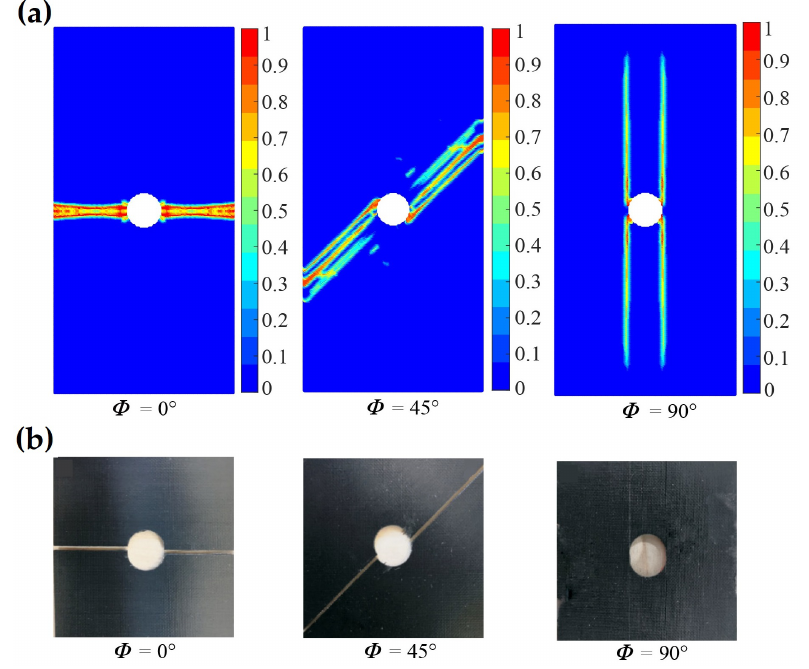
Figure 7. Damage of laminas of different fiber directions. ( a ) Simulation results for different fiber directions. ( b ) Experimental results for different fiber direction